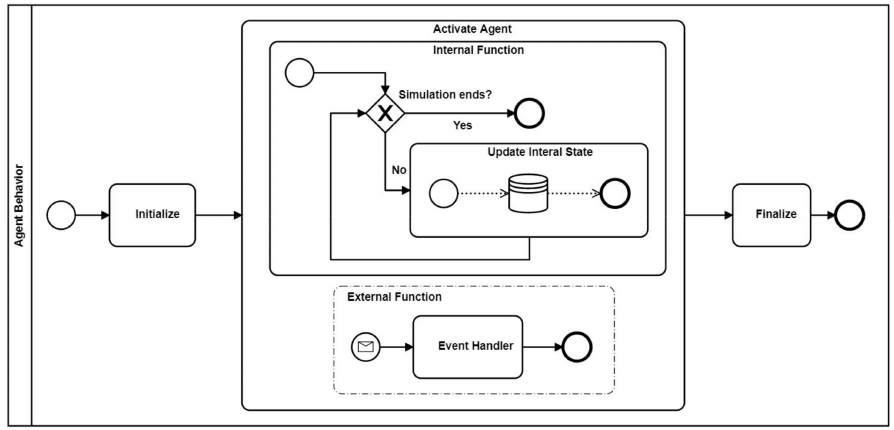
Figure 4. Agent behavior